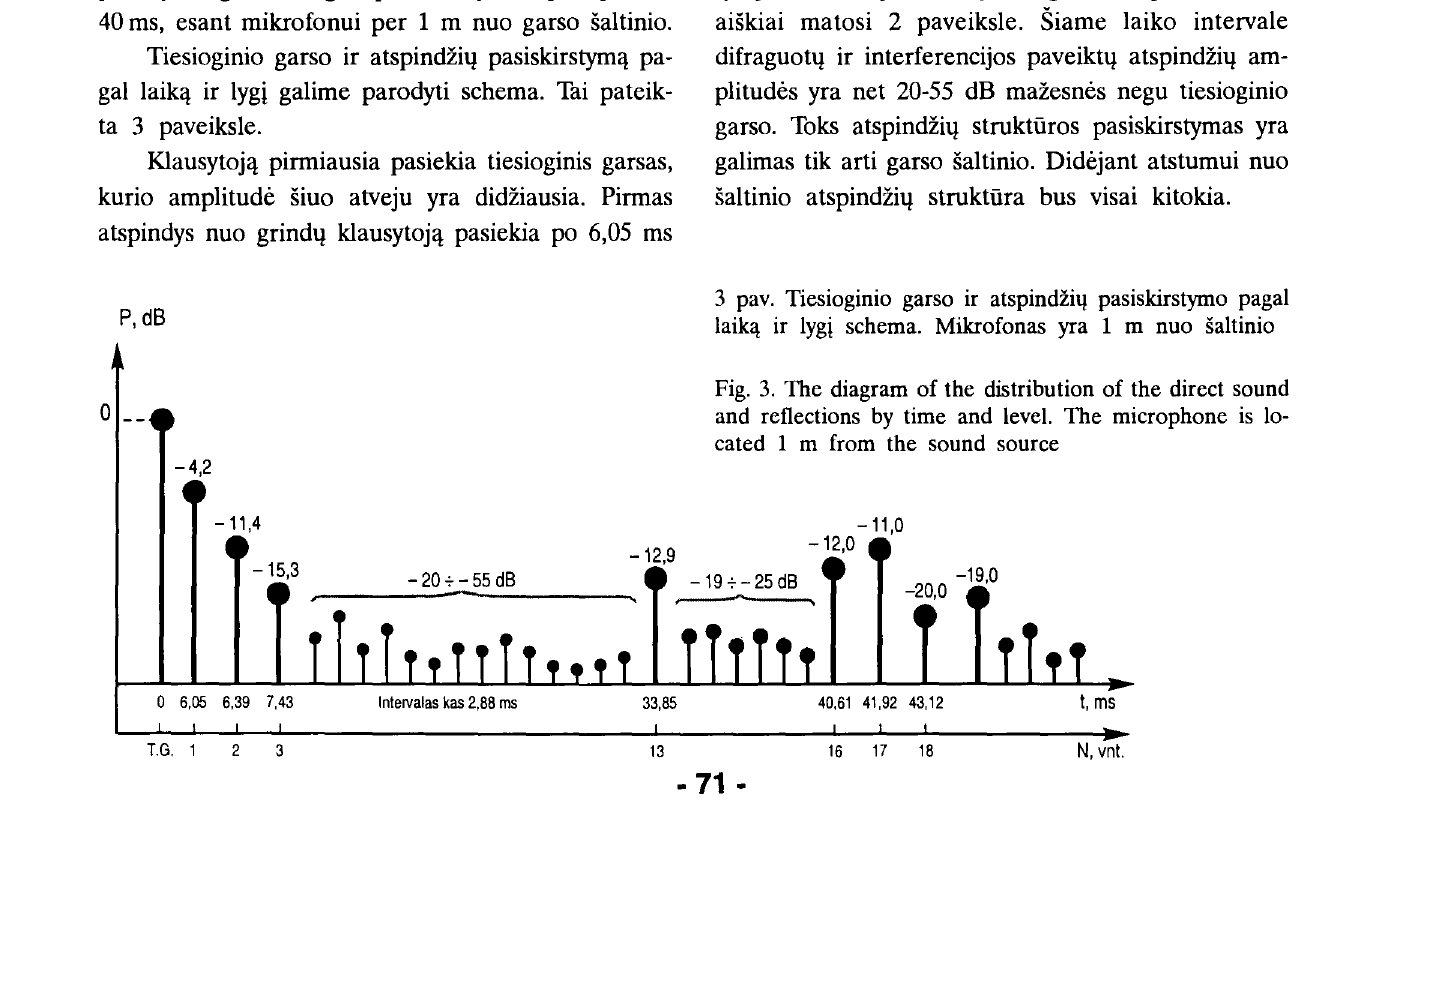
2 pav. Tiesioginio ir atsispindejusio garso s!egio pasiskir stymas nefiltruotame signale per pirmas 40 ms. Mikrofo nas yra 1 m nuo saltinio Fig. 2. The distribution of the direct sound pressure and the reflected sound pressure in the nonfiltered signal over the first 40 ms. The microphone is located 1 m from the sound source ir jo amplitude yra tik 4,2 dB mazesne negu tiesio ginio garso. Po 6,39 ir 7,43 ms ateina du atspin dziai, kuriq amplitudes jau yra 11,4 dB ir 15,3 dB mazesnes, negu tiesioginio garso. Kitas garso at spindys nuo lubq klausytojq pasiekia tik po 33,85 ms. Laiko intervale nuo 6,6 ms iki 33,35 ms klau sytojo visai nepasiekia jokie garso atspind:Ziai. Tai aiskiai matosi 2 paveiksle. Siame laiko intervale difraguotq ir interferencijos paveiktq atspindziq am plitudes yra net 20-55 dB mazesnes negu tiesioginio garso. Toks atspindziq struktiiros pasiskirstymas yra galimas tik arti garso saltinio. Didejant atstumui nuo saltinio atspindziq struktiira bus visai kitokia.